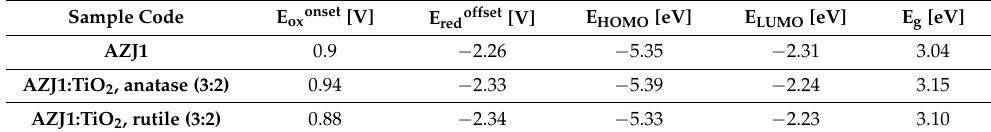
Table 2. Electrochemical and energy level parameters of AZJ1 mixed with TiO 2 .